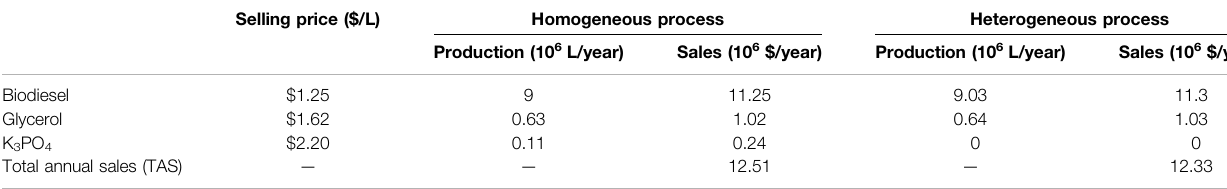
TABLE 4 | Market prices, annual production, and total sales of products for the homogeneous and heterogeneous processes. Selling price ($/L)